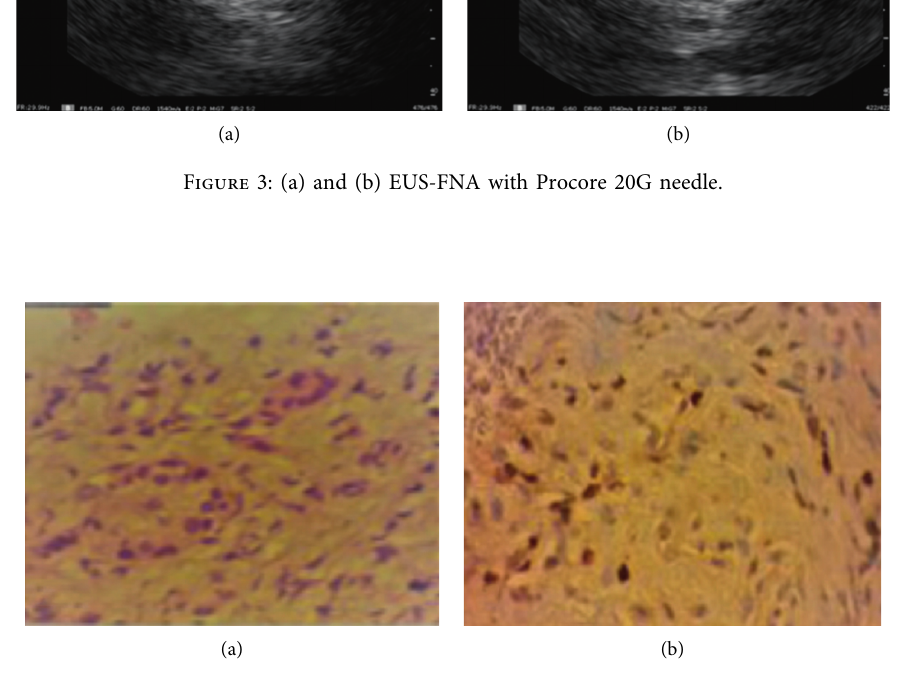
Figure 4: Material obtained through EUS-FNA and sent for histological and immunohistochemical study. (a) Hematoxylin-eosin revealing atypical microducts and (b) GATA3-labeled immunohistochemistry (+) -secondary breast